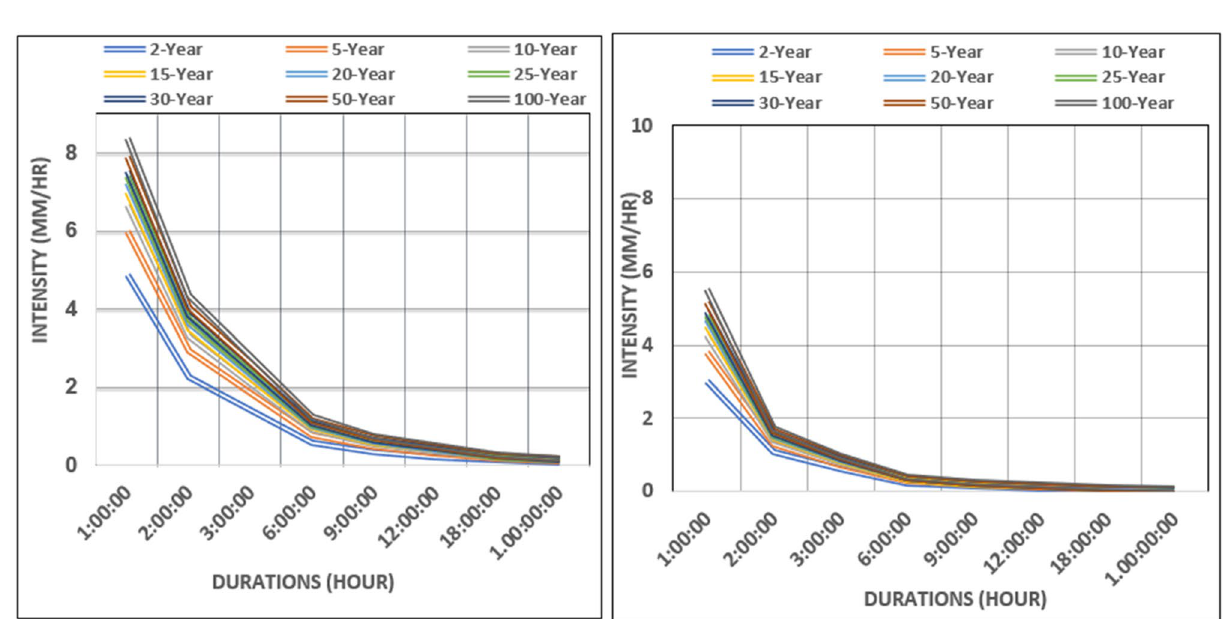
Figure 7. Comparison of intensity duration frequency (IDF) between historical and future